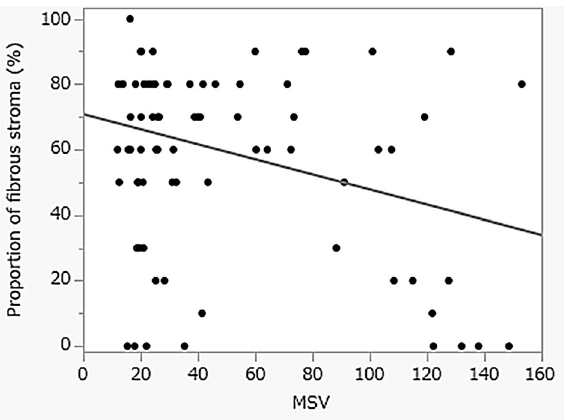
Figure 4. The correlation between the mean strain value at the puncture site and the proportion of fibrous stroma in the core tissue in cases of pancreatic ductal adenocarcinoma. (R 2 = 0.1226: P =